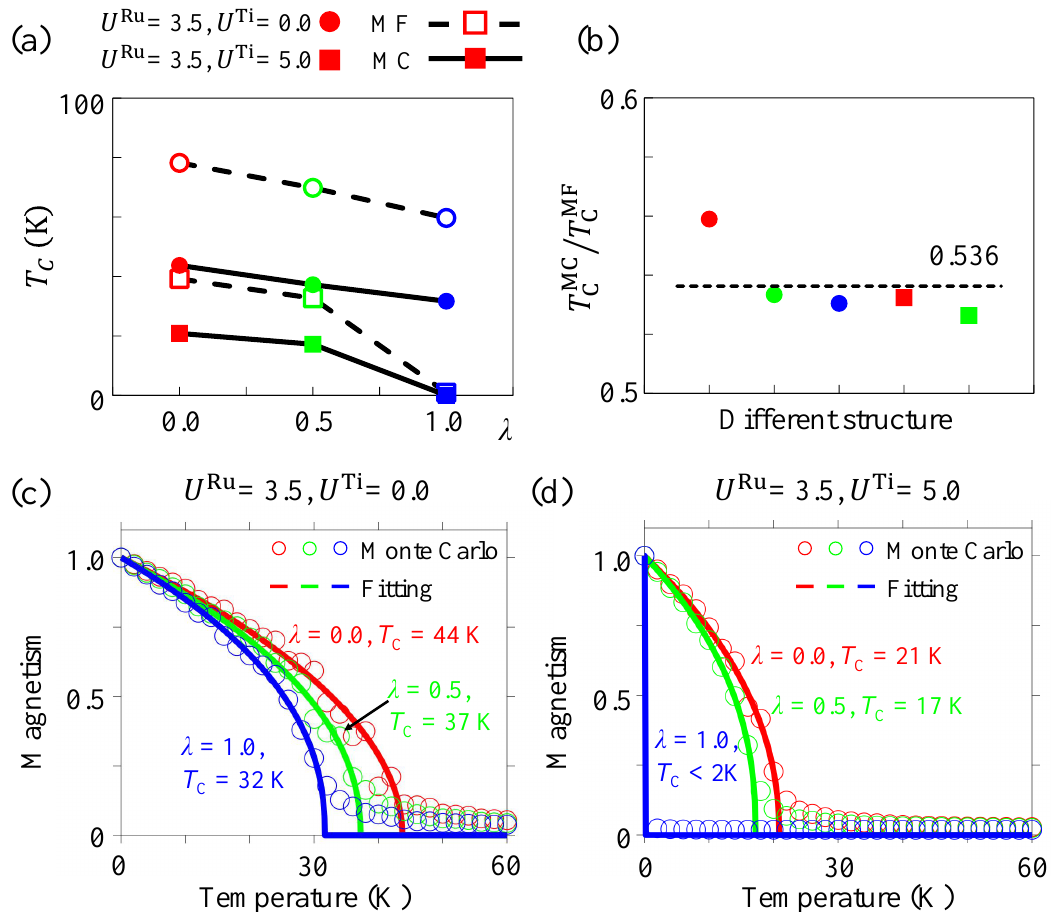
Figure 3. ( a ) Mean field and Monte Carlo T C of different lattice constants and U Ti in SRO/STO superlattice. λ = 0 indicates using the SRO lattice constants a , b , while λ = 1 indicates that the STO lattice constants a , b are used. The solid (dashed) line indicates the Monte Carlo (mean field) result. The circle (square) symbol indicates the U Ti = 0.0 eV (5.0 eV) cases. ( b ) The ratio T MC considered cases. The dashed line represents the average ratio of 0.536. ( c , d ) The Monte Carlo and the fitting magnetization of SRO/STO